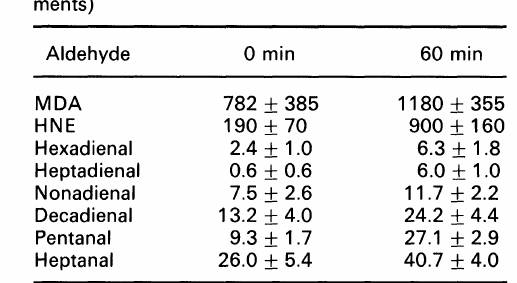
Table 1. Levels of aldehydic products of lipid peroxidation in hepatocyte suspensions treated 60min with mM CBrCI3. Values are given as nmol/I cell suspension" mean-t-S.D. (six experi-